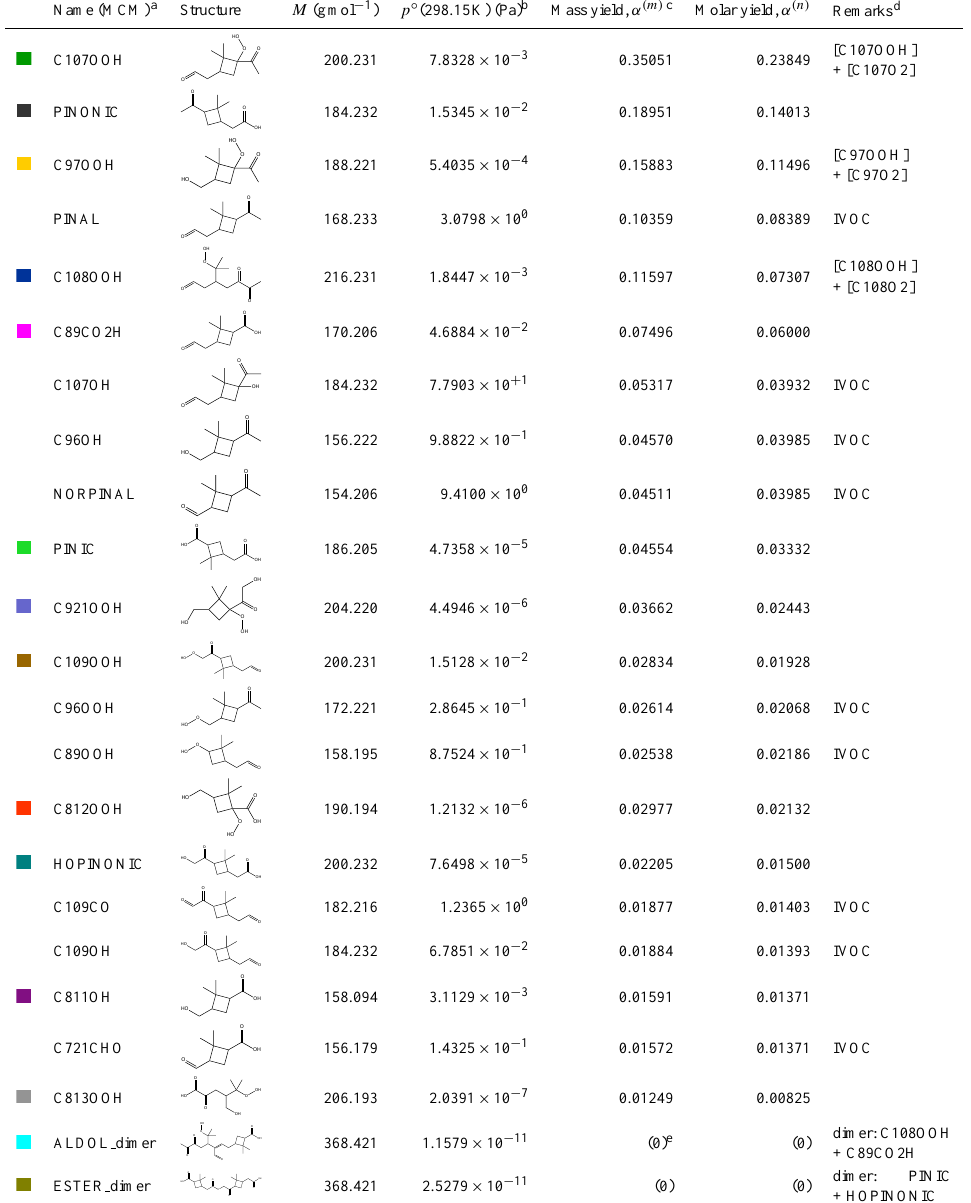
Table 1. Oxidation products and corresponding yields predicted by the MCM model v3.1 (Jenkin et al., 1997; Saunders et al., 2003) for the dark ozonolysis of α -pinene. List of species and corresponding stoichiometric yields are derived from the MCM chamber simulation reported by Shilling et al. (2009) for the reaction of 0 . 9ppbv α -pinene. Simulation conditions: T = 298 . 15K, 40% RH, 300ppbv ozone, 0 . 94ppmv 1-butanol, dry ammonium sulfate seed particles, and 3 . 4h residence time. System components for the gas-particle partitioning calculations are indicated by the colored symbols (mostly non-IVOC